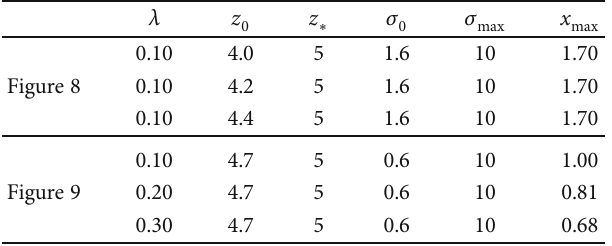
Table 5: Parameter values used for plots in Section 4.